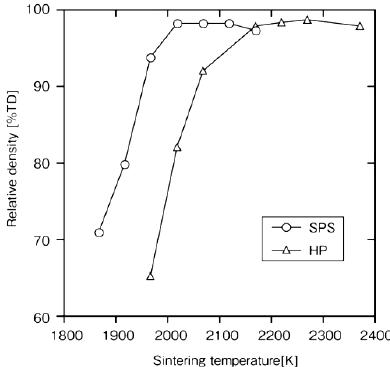
Figure 18. Dependence of relative density on the sintering temperature in the SPS- and HP-consolidated SiCs.